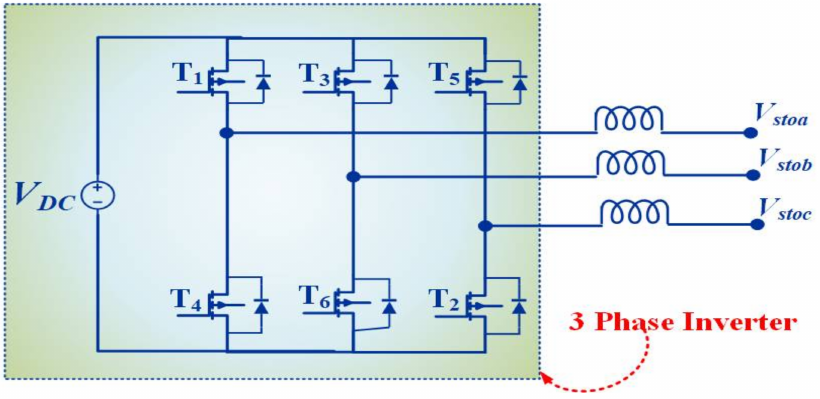
Figure 4. Representation of the Voltage Source Converter (VSC) for the